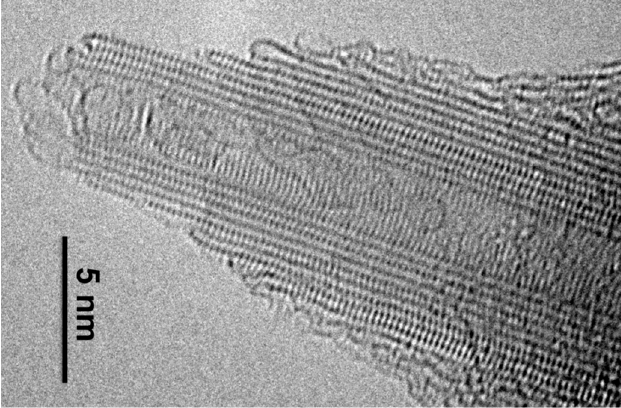
Figure 7. High resolution transmission electron microscopy (HRTEM) image of the nano-sized apex of an all-graphene carbon cone. Dots are carbon atoms. Several examples of buckling graphenes forming loops are seen. (Photo credit: R. Wang, CEMES-CNRS).